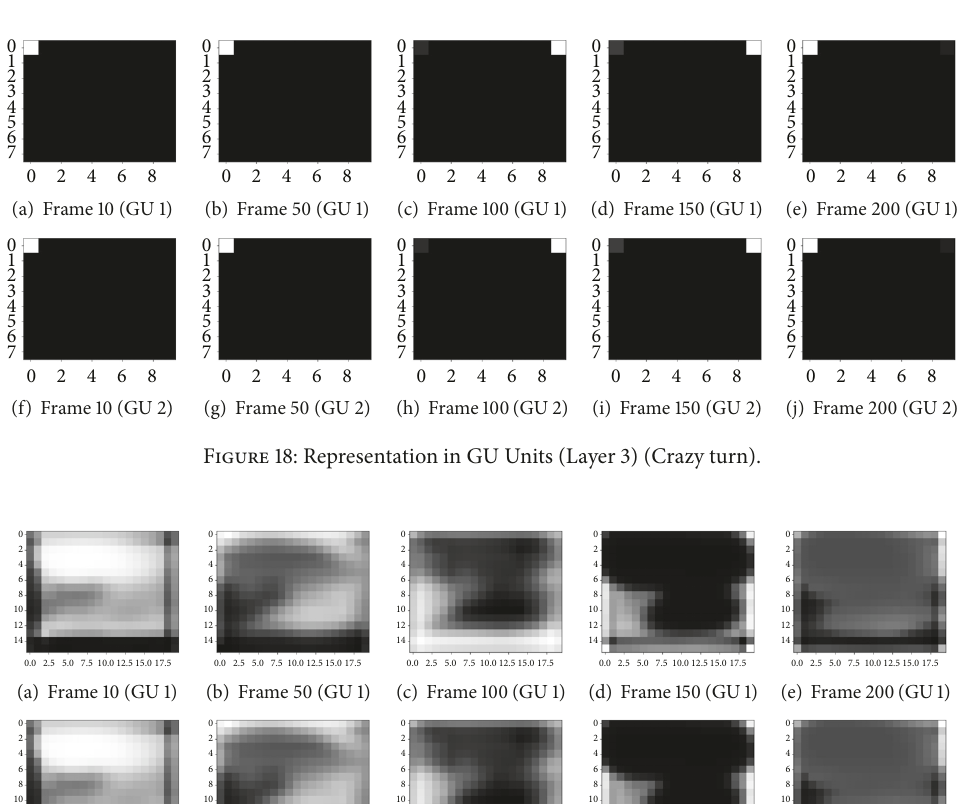
Figure 17: Representation in GU Units (Layer 2) (Crazy turn).